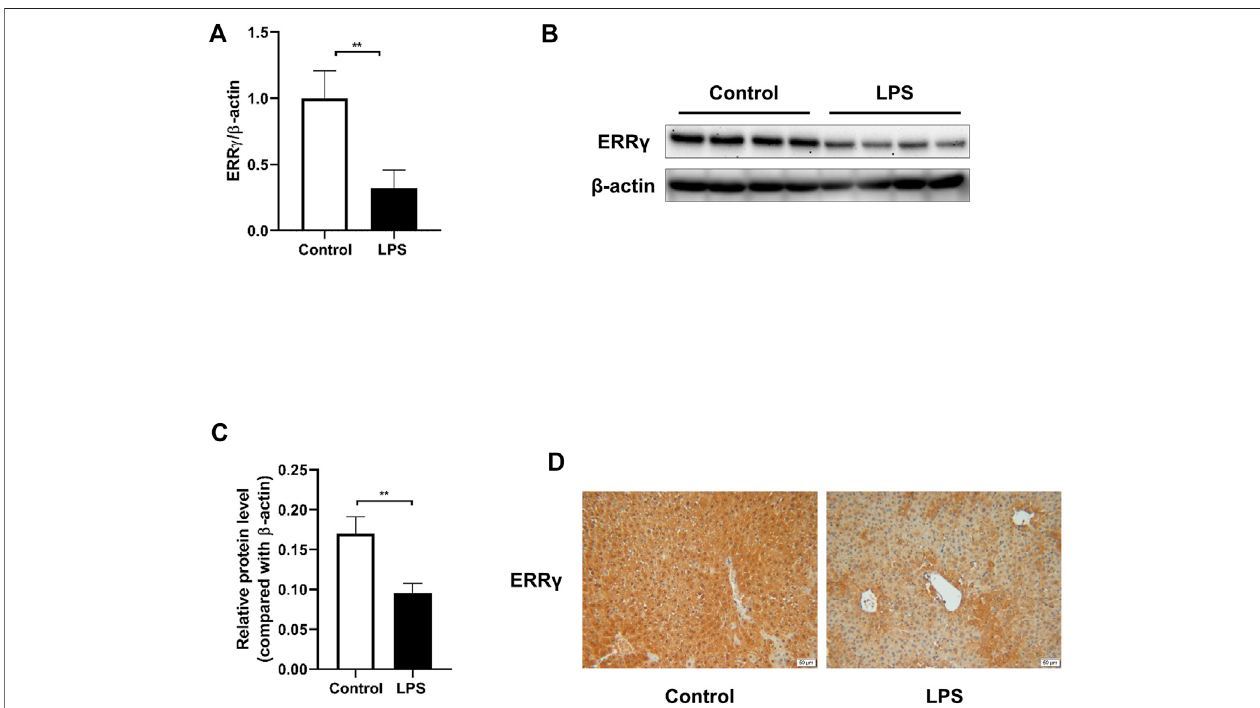
FIGURE1 | LPS challenge downregulatedERR γ expression in mouse livers. LPS at the dose of10 mg/kg or saline (control) was administered tothe male C57BL/ 6 Jmiceintraperitoneally, thenmice weresacri fi cedafter 24 h. (A) mRNAexpression ofERR γ determined byqRT-PCR(n (cid:1) 10ineach group). (B) Western blotofERR γ (n (cid:1) 8 in each group). (C) Quantitative analysis of ERR γ by densitometry (n (cid:1) 8 in each group). (D) Representative images of immunohistochemical staining of ERR γ in livers from mice in the control and LPS groups (magni fi cation × 200, scale bar: 50 μ m, n (cid:1) 5 in each group). Data were presented as means ± SEM. ** p < 0.01 vs. control